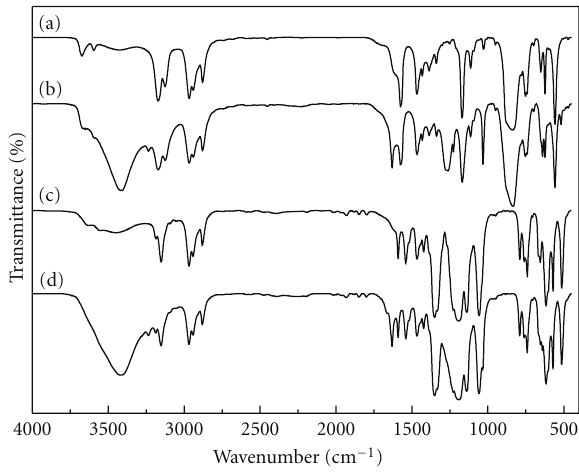
Figure 3: FTIR spectra of (a) BMImPF 6 , (b) 0.3molL − 1 Mg(CF 3 SO 3 ) 2 /BMImPF 6 , (c) BMMImTFSI, and (d) 0.3molL − 1 Mg(CF 3 SO 3 ) 2